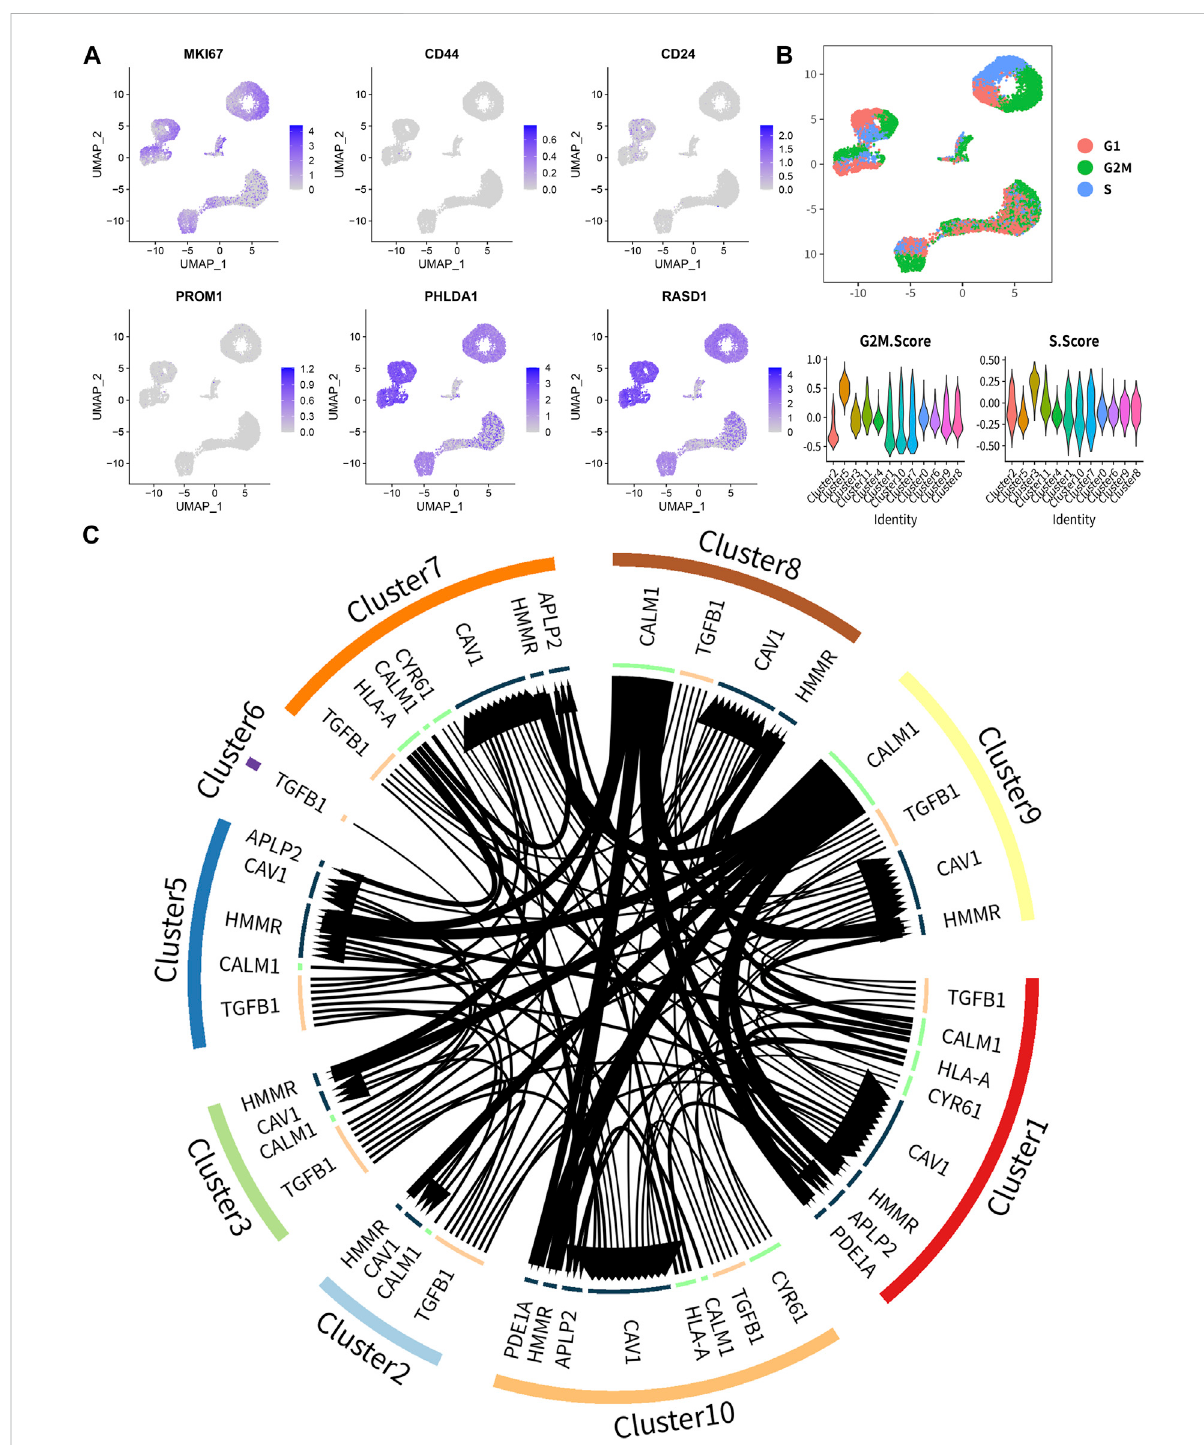
FIGURE 9 The key biomarkers extensively expressed in Ewing sarcoma stem cell. (A) The distribution of marker genes, and MKI67, PHLDA1 and RASD1 were extensively high expressed in all clusters. (B) The cell cycle distribution and the cell cycle score in 12 clusters. (C) The ligand-receptor pairs among 12